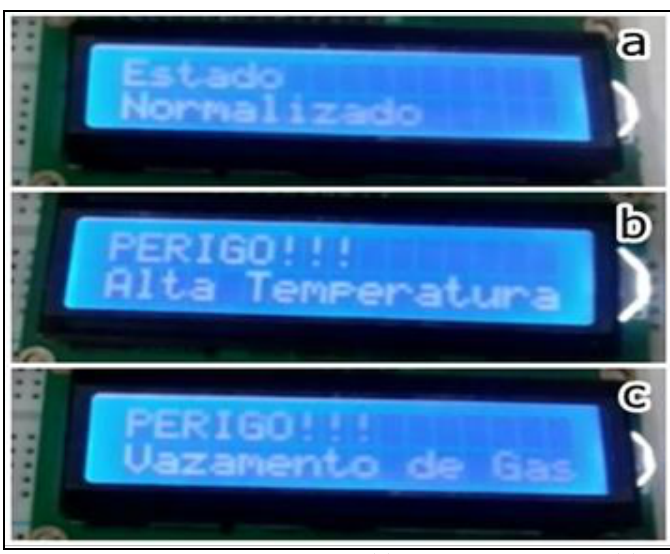
Figura 12: Estado normalizado (a), alta temperatura (b) e vazamento de gás (c). Fonte: Autores,